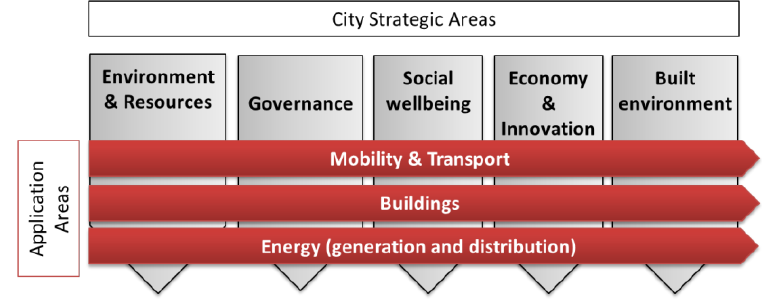
Figure 5. Level 1 indicators matrix: City Strategic Areas and Application Areas [ Error! Reference source not found.